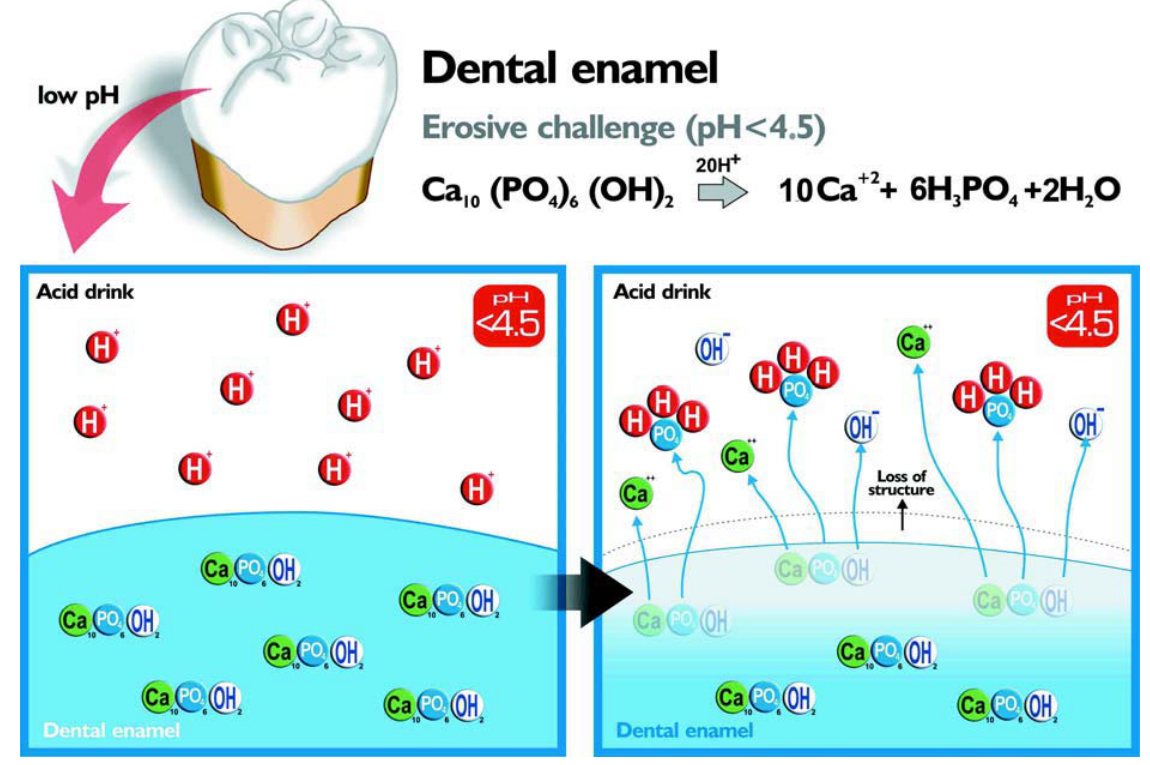
FIGURE 6- Erosive demineralization of dental enamel (pH<4.5)